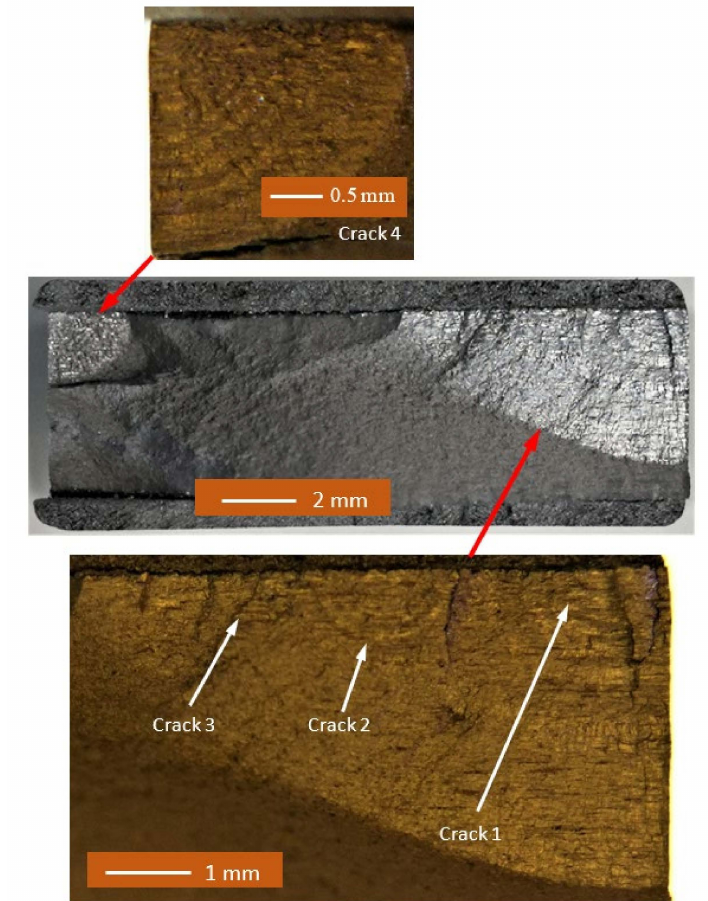
Figure 2. Failure surface associated with test specimen